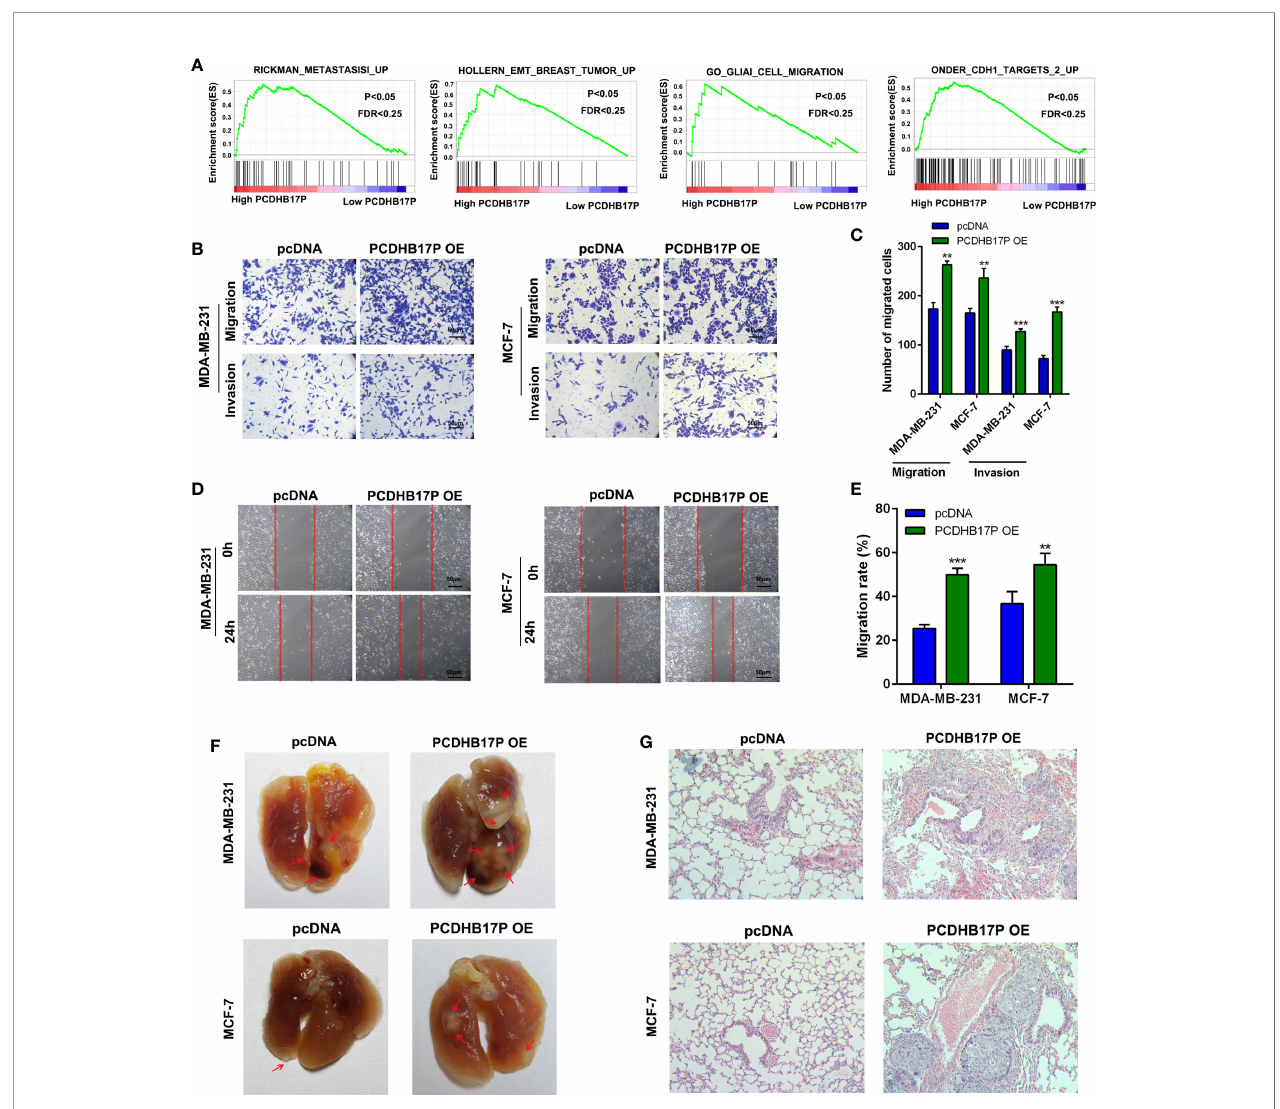
FIGURE 2 | PCDHB17P promotes metastasis of Breast cancer cells (A) GSEA revealed that PCDHB17P expression was related to metastasis in breast cancer. (B – E) In fl uence of PCDHB17P overexpression on cell migration and invasion of MDA-MB-231 and MCF-7 cells by the transwell and wound healing assays. (F, G) MDA-MB-231 and MCF-7 cells stably overexpressing PCDHB17P were injected into the tail vein of mice to construct a lung metastasis model. Representative images of macroscopic metastatic nodules on lung and HE staining results. ** P < 0.01, *** P <